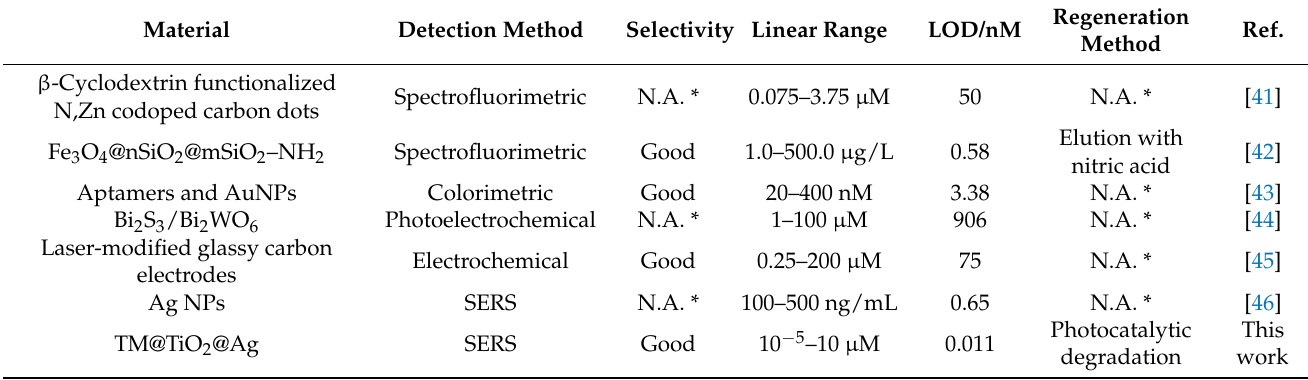
Table 2. Comparison of the present method with those reported in recent